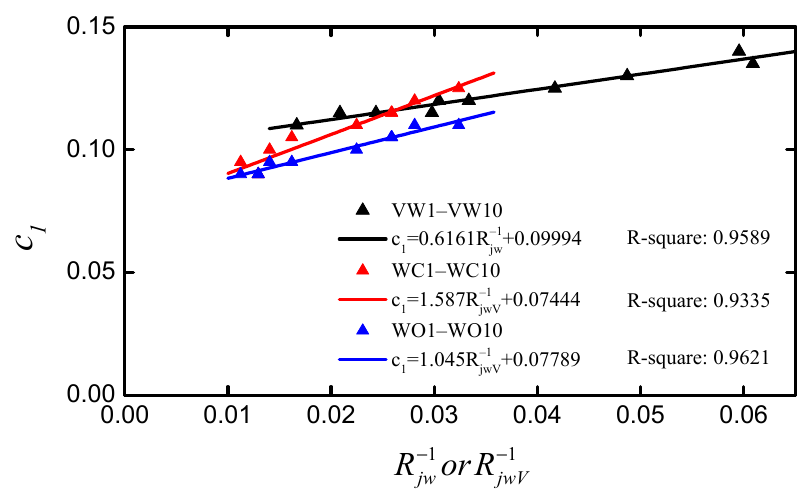
c versus 1 R − or 1 R − for the vertical jet (shown in black or R − 1 for the vertical jet (shown in black line), jw jwV 1 jw jwV